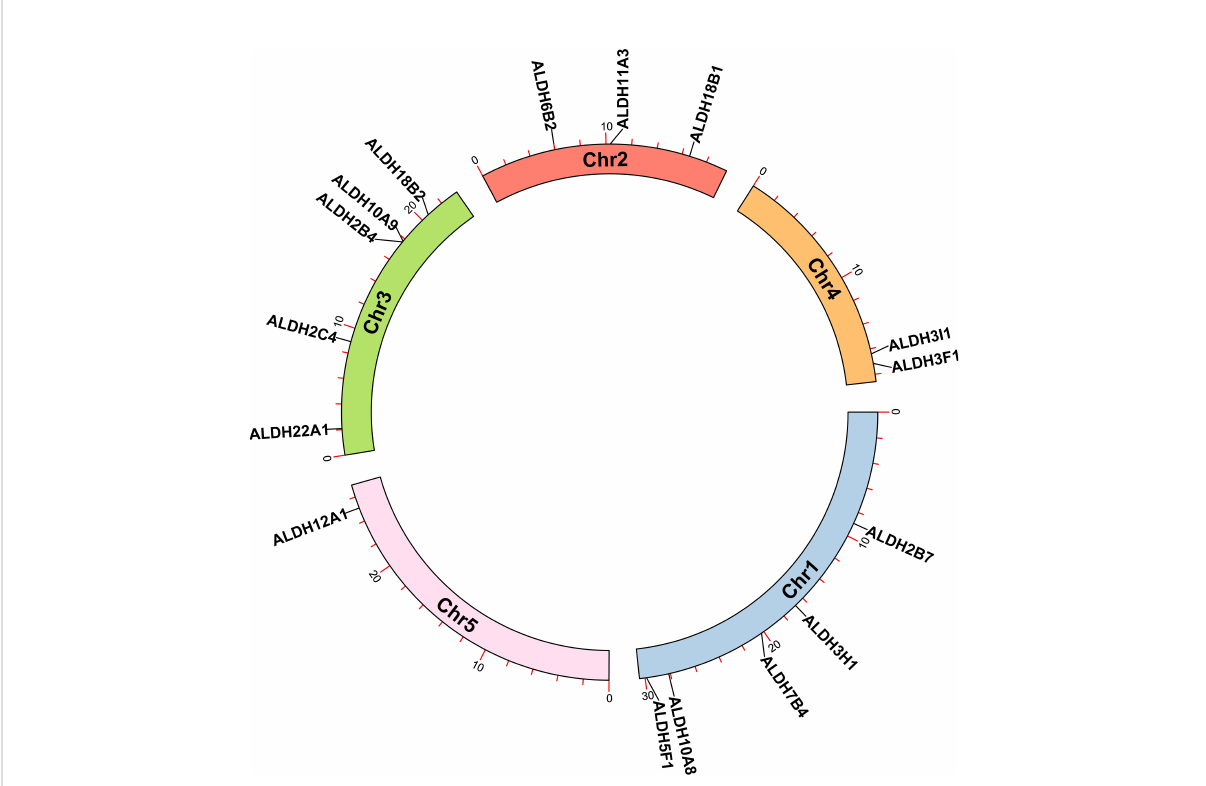
FIGURE 2 Chromosomal localization of ALDH genes in Arabidopsis. All 16 AtALDH genes were indicated on 5 different chromosomes of Arabidopsis with a black label. Arabidopsis chromosome length and AtALDH gene localization on chromosomes were derived from Ensemblplants (http://plants.